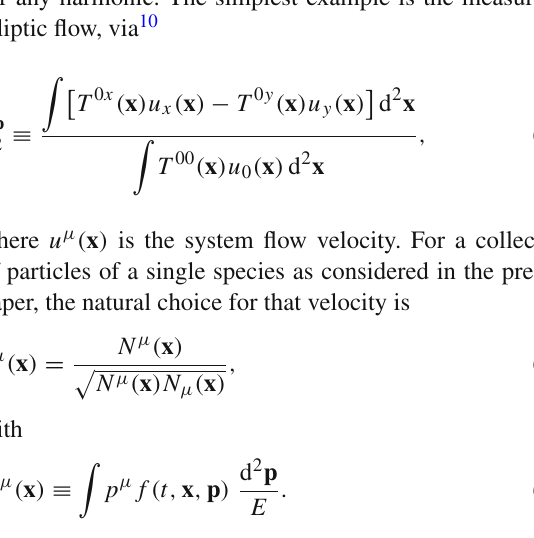
Fig. 14 Time dependence of α p for simulations (full lines) in a colli- 2 sionless(green)systemorinthefewcollisionsregime(orange),together with the analytical result in the free streaming case (dotted blue line)